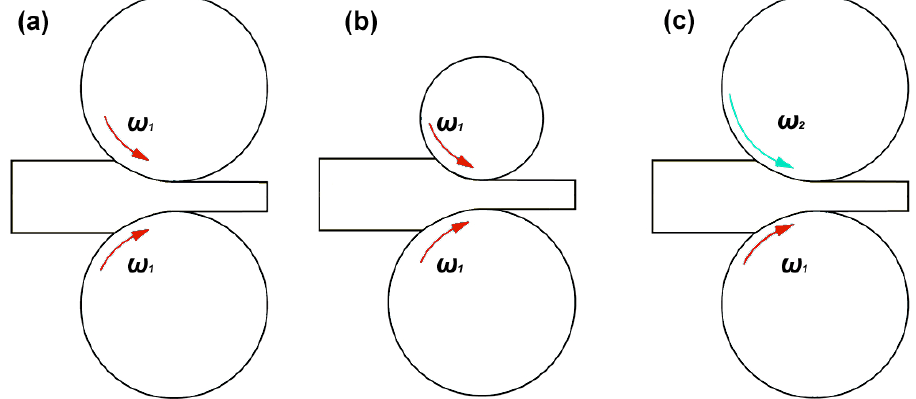
Figure 1. A schematic drawing of: ( a ) symmetry rolling process, ( b ) asymmetry with different roll diameters, ( c ) asymmetry with a differential rotation speed of rolls.